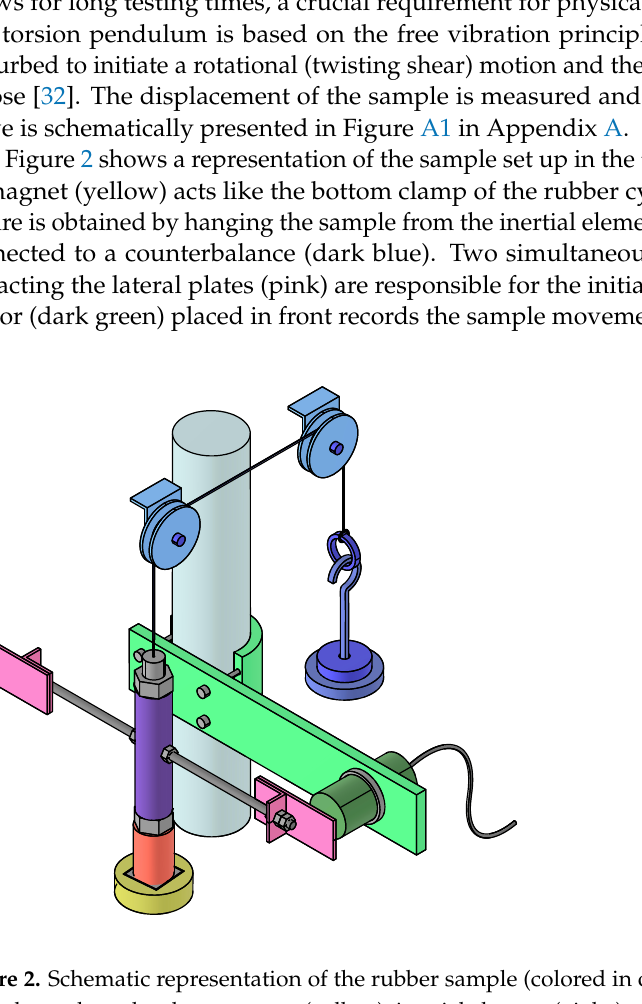
Figure 2. Schematic representation of the rubber sample (colored in orange) placed on the torsion pendulum where the electromagnet (yellow), inertial element (violet), counterbalance (dark blue), lat- eral plates (pink), and sensor (dark green) are shown. The complete setup and guidelines description can be found in Vizcaíno-Vergara et al.